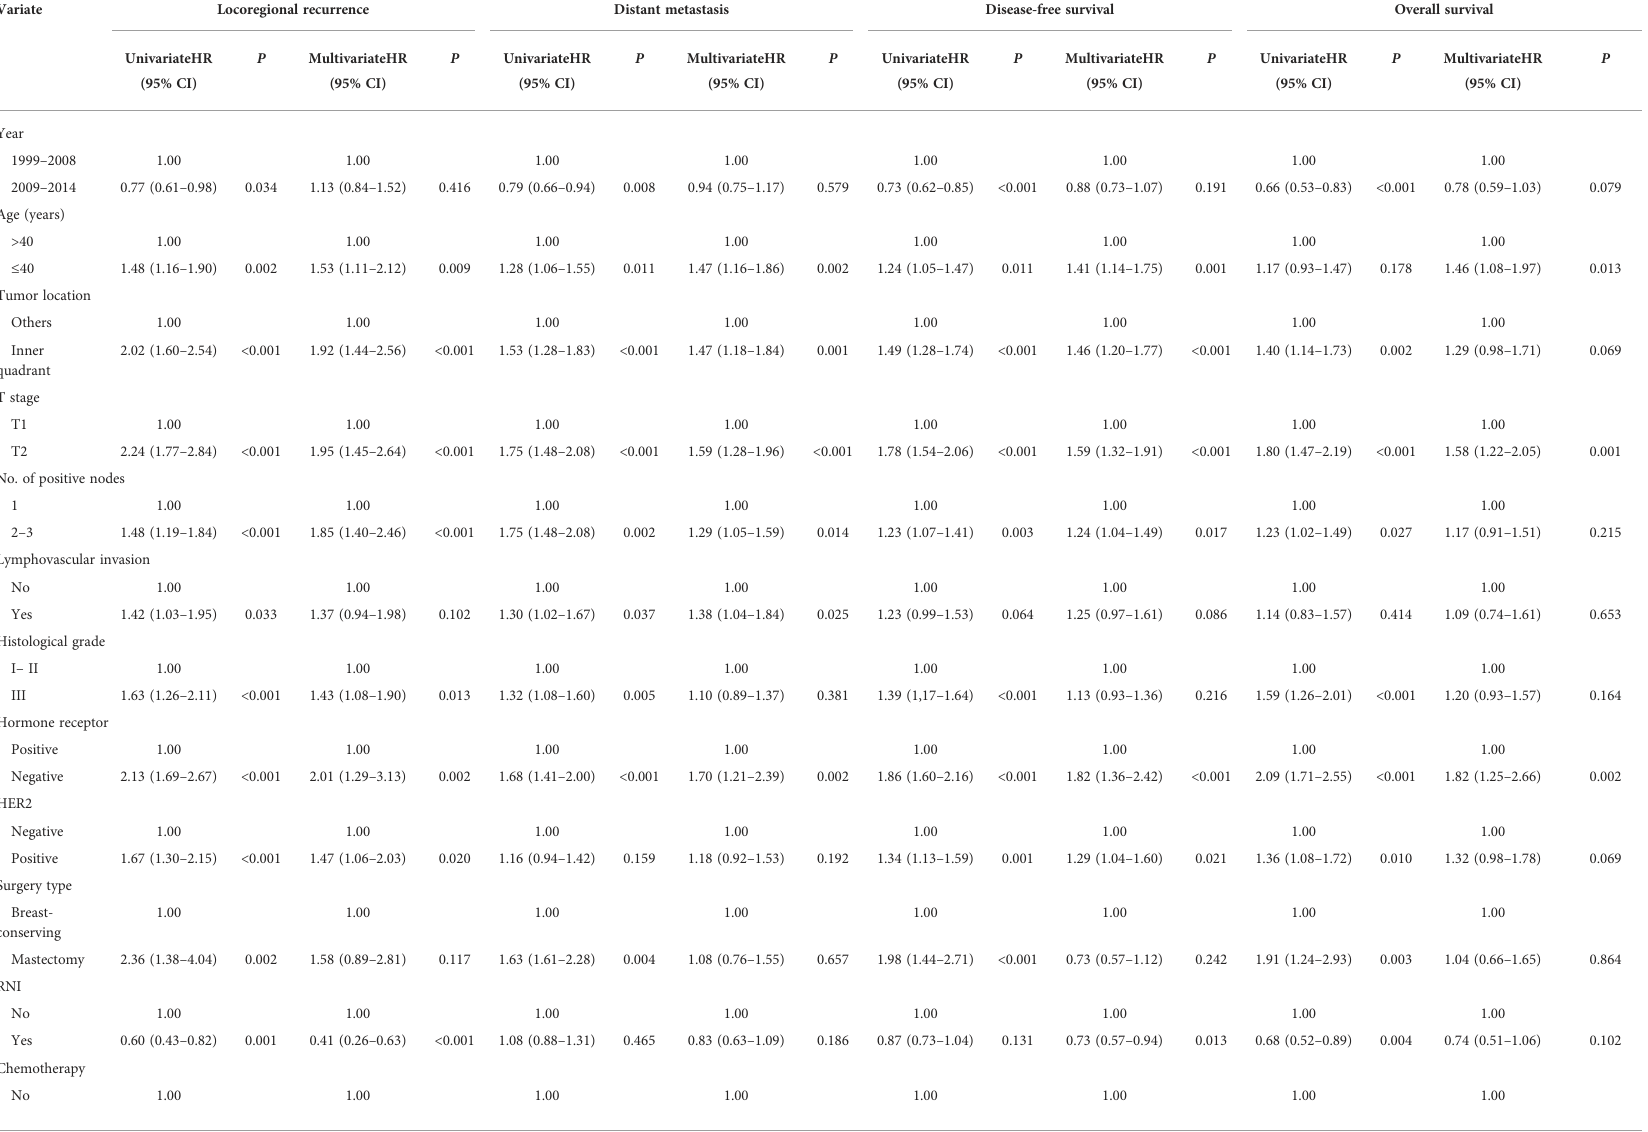
TABLE 2 Univariate and multivariate analyses of risk factors for outcome events. Variate Locoregional recurrence Disease-free